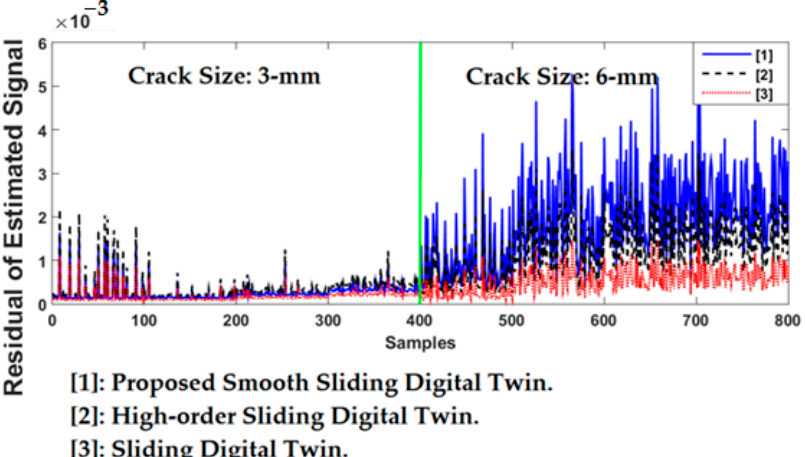
Figure 18. The accuracy of crack size identification for inner-ball residual of RMS signals using proposed smooth sliding digital twin, high-order sliding digital twin, and sliding digital twin.